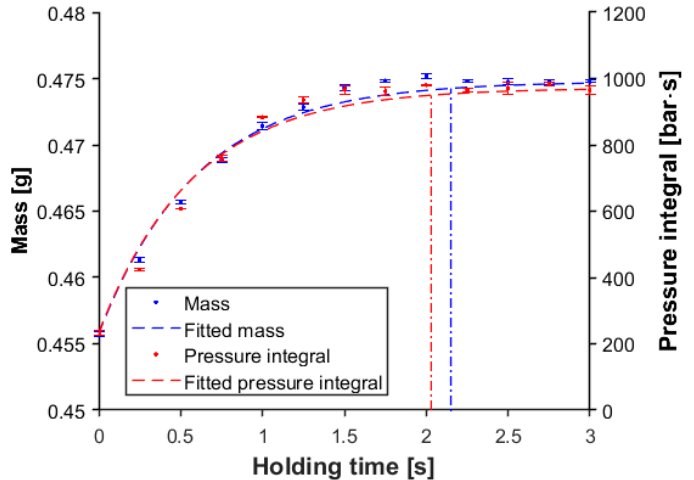
Figure 14. Mass and pressure integral as a function of holding time (cavity no. 1, post-gate sensor, p hold = 600 bar, integration time 3 s).